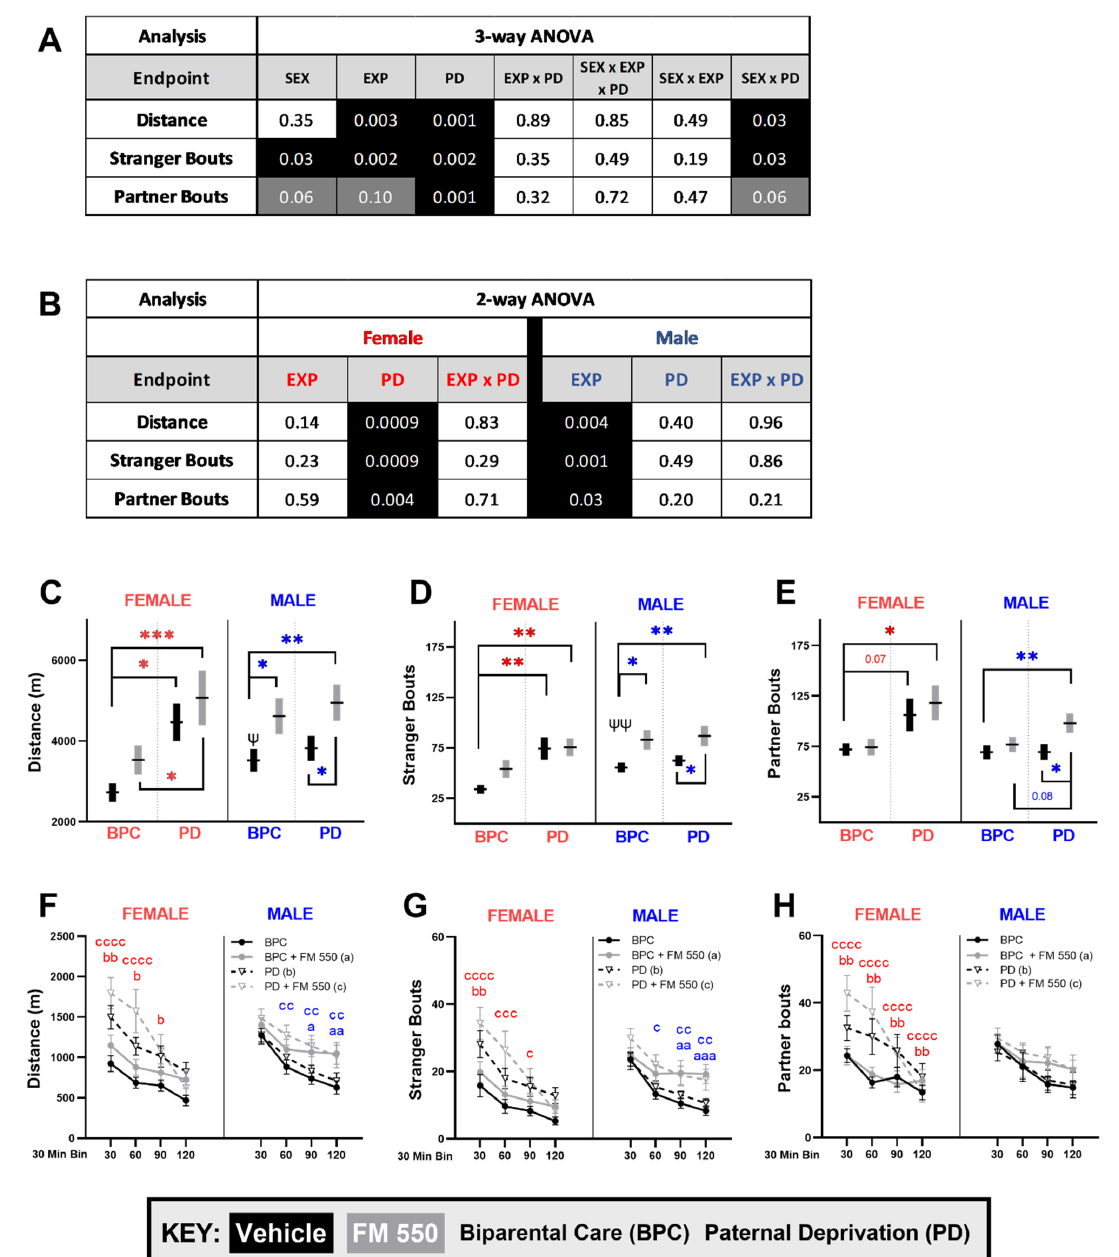
Figure 5. PP exploratory behavior in the partner preference test. ( A ) Three-way ANOVA p -values for main effects of sex, exposure, paternal deprivation, and interaction for each endpoint. Significant effects are highlighted in black and suggestive effects ( p ≤ 0.10) are highlighted in grey. ( B ) Two- way ANOVA p -values within sex. Main effects of exposure were only seen in males, while the main effects of PD were only observed in females. ( C ) Effects on distance traveled were influenced by paternal care in females but exposure in males, with co-exposed females traveling more than any